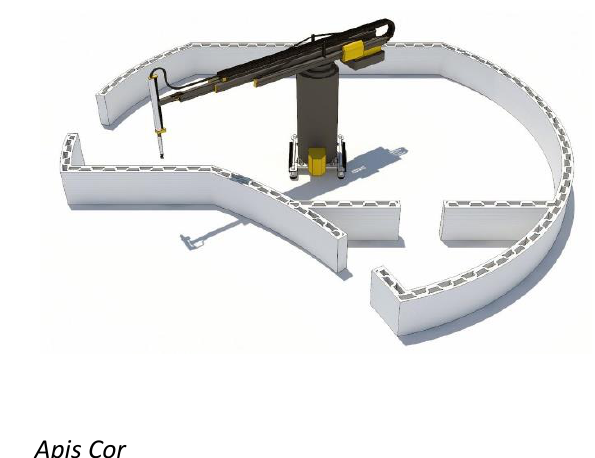
Source: conrad.it inhabitat.com